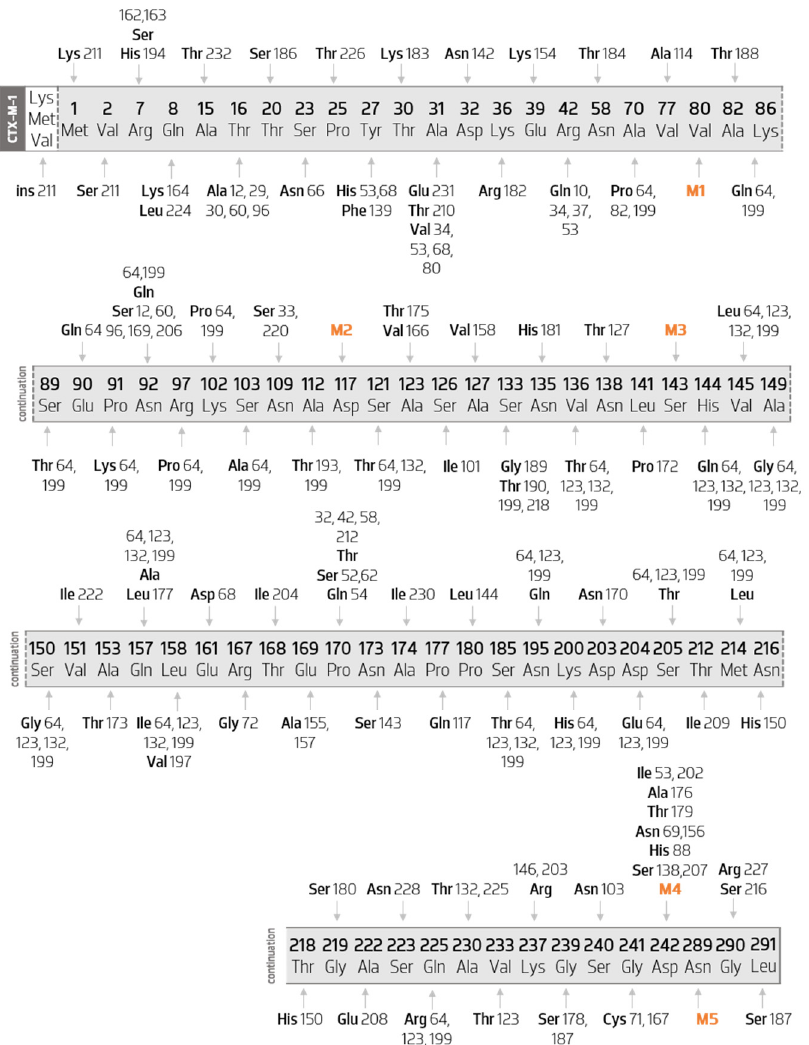
Figure 4. Diagram of the several mutations of the members of CTX-M-1 cluster when compared with the CTX-M-1 sequence. Scheme based on available sequences and phenotype in Bacterial Antimicrobial Resistance Reference Gene Database, in which five major hotspots are represented by Val80Ala (M1), Asp117Asn (M2), Ser143Ala (M3), Asp242Gly (M4), and Asn289Asp (M5). key substitutions: Val80Ala, Asp117Asn, Ser143Ala, Asp242Gly, and Asn289Asp. In Table 1